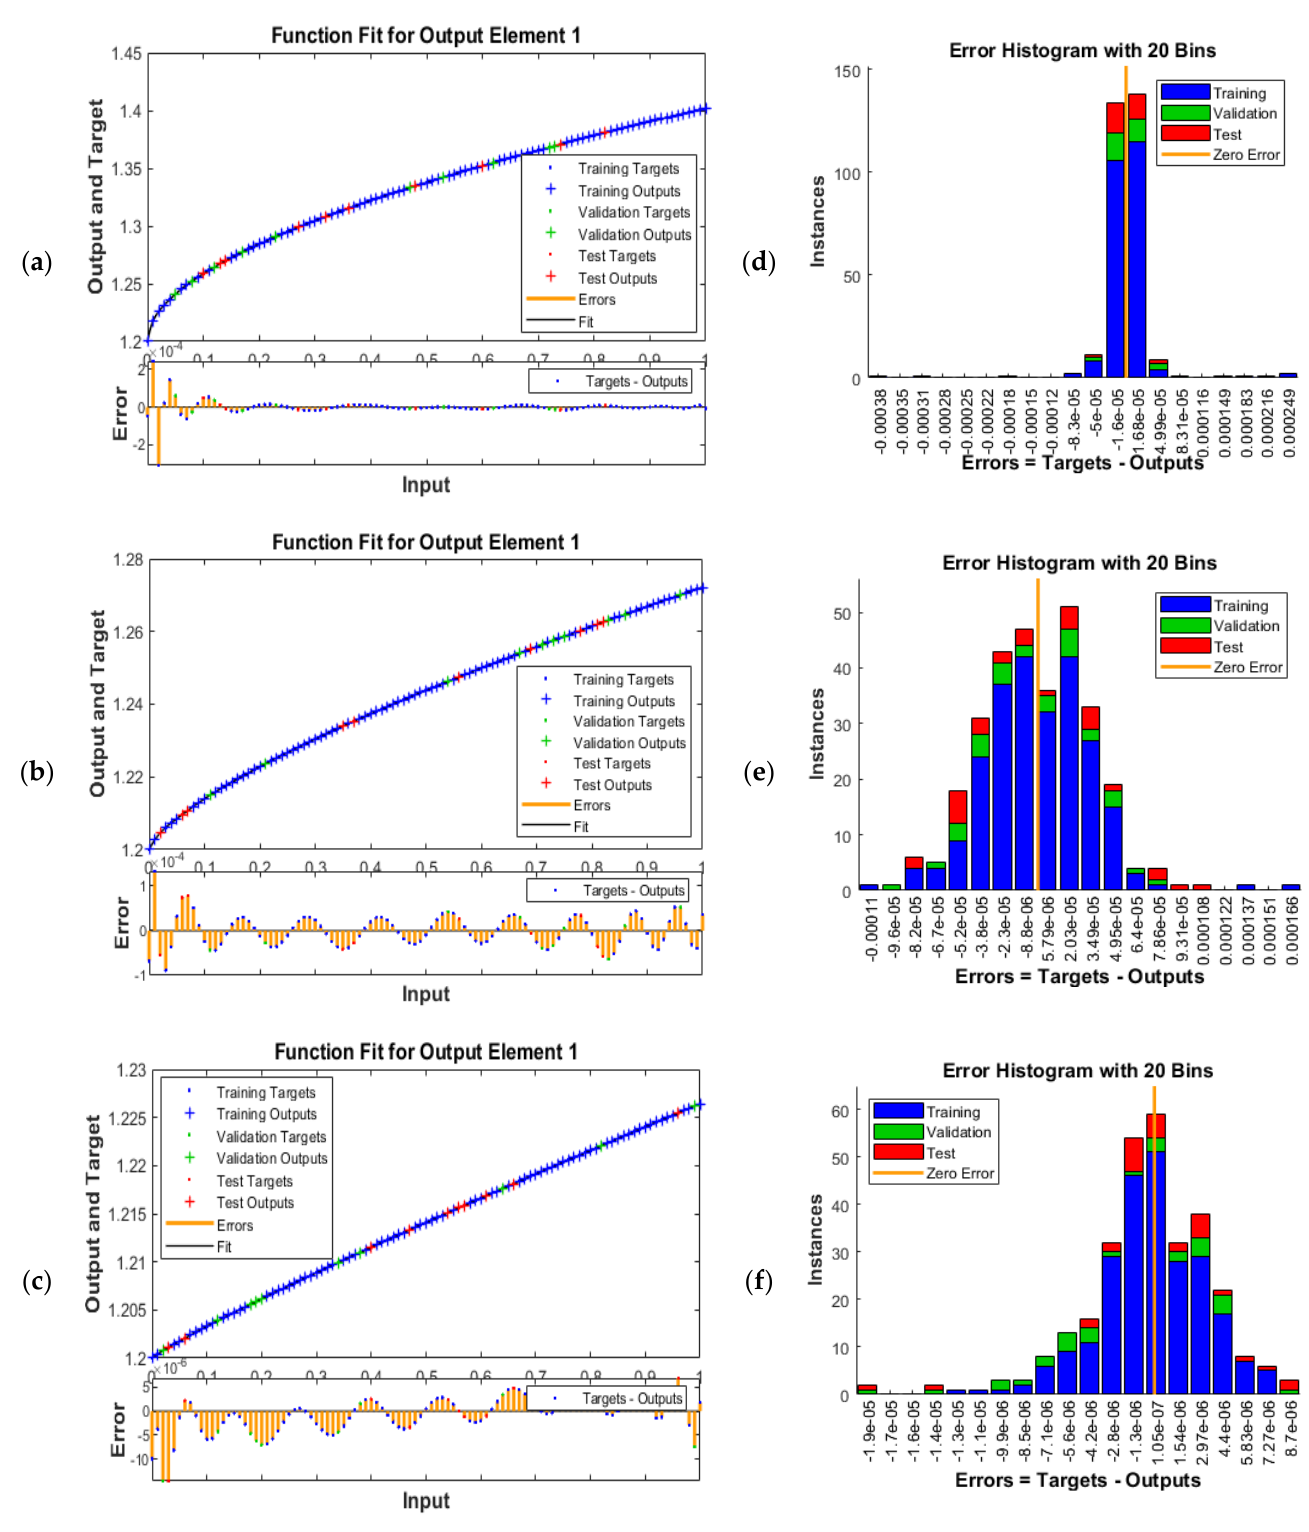
Figure 4. Results valuations and EHs for the mathematical form of the FKFS model. ( a ) Result measures for C-1; ( b ) Result measures for C-2; ( c ) Result measures for C-3; ( d ) EHs for C-1; ( e ) EHs for C-2; ( f ) EHs for C-3.